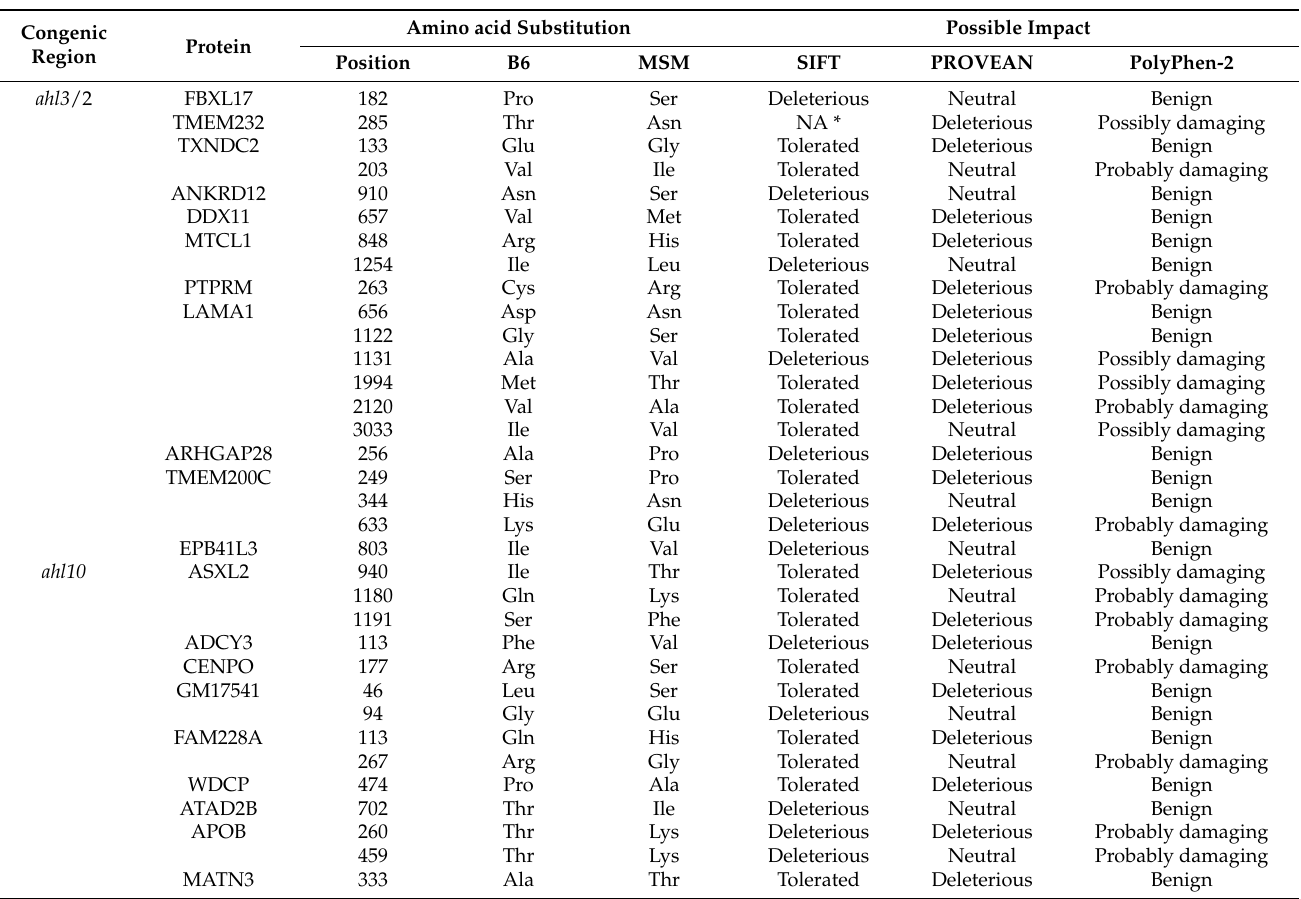
Table 1. Amino acid substitutions that allow for potential phenotypic differences between B6